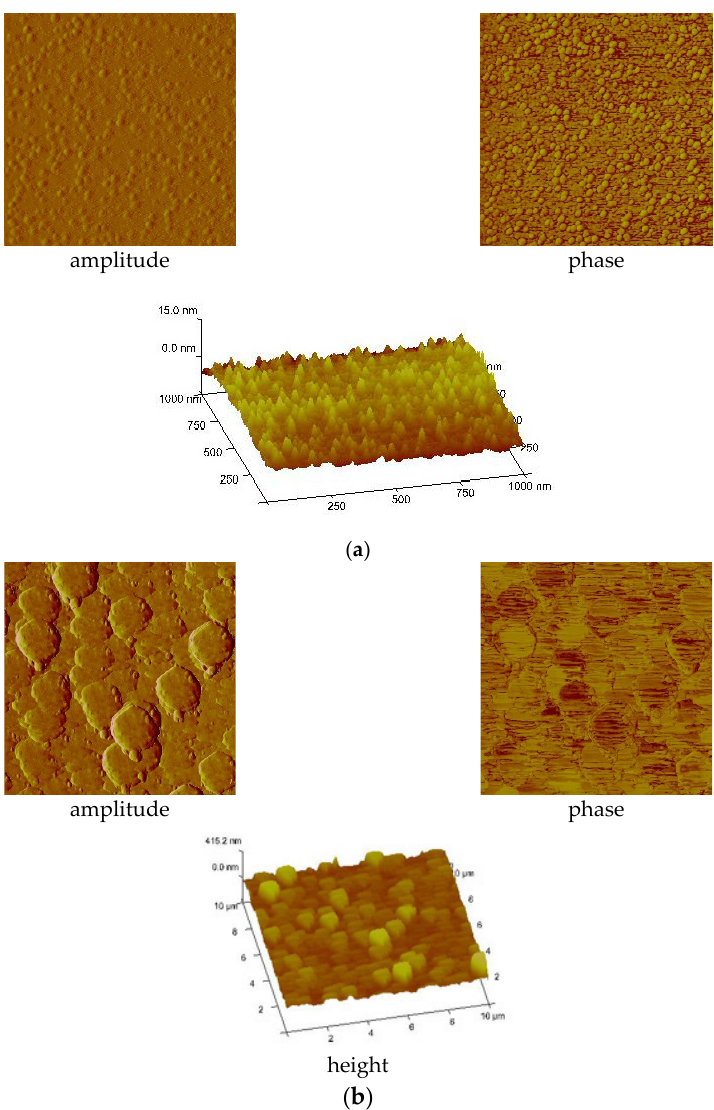
Figure 16. AFM images of [Cu 2 (EtNH 2 ) 2 (µ-O 2 CC 2 F 5 ) 4 ] ( 2 )/Si ( a ) before, ( b ) after heating (multistage process: 800 rpm, 10 s, 600 rpm, 10 s, 600 rpm, 10 s, drying 3000 rpm, 60 s).